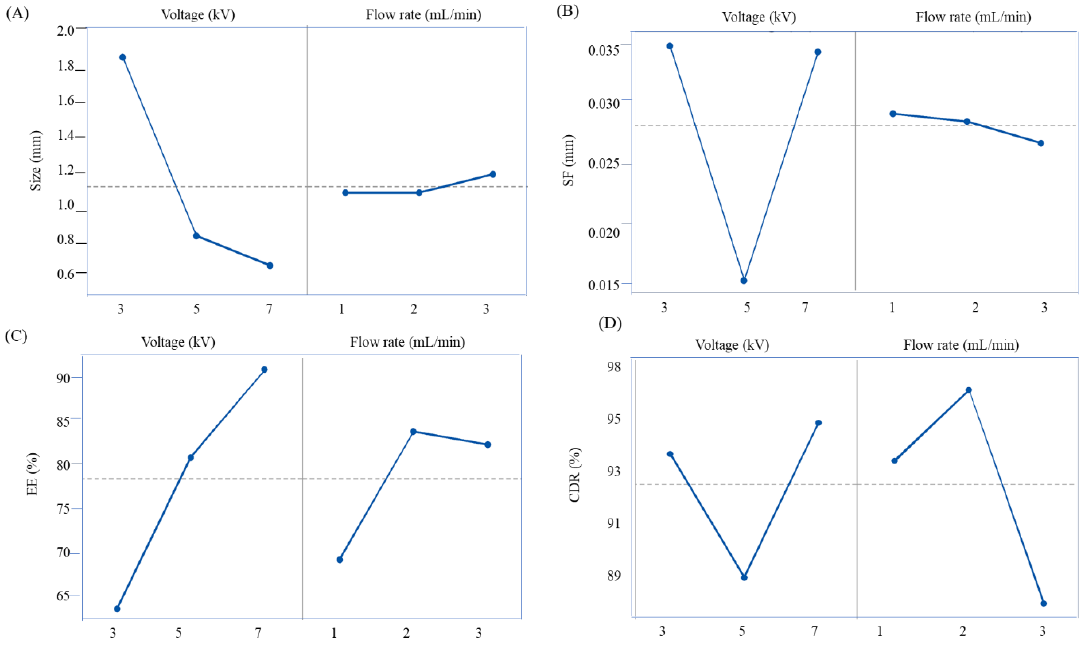
Figure 3. Main effects plot of alginate beads on size ( A ), sphericity factor (SF) ( B ), encapsulation efficiency (EE%) ( C ), % cumulative drug release at 2 h ( D ). Data were presented as mean value ( n = 3).